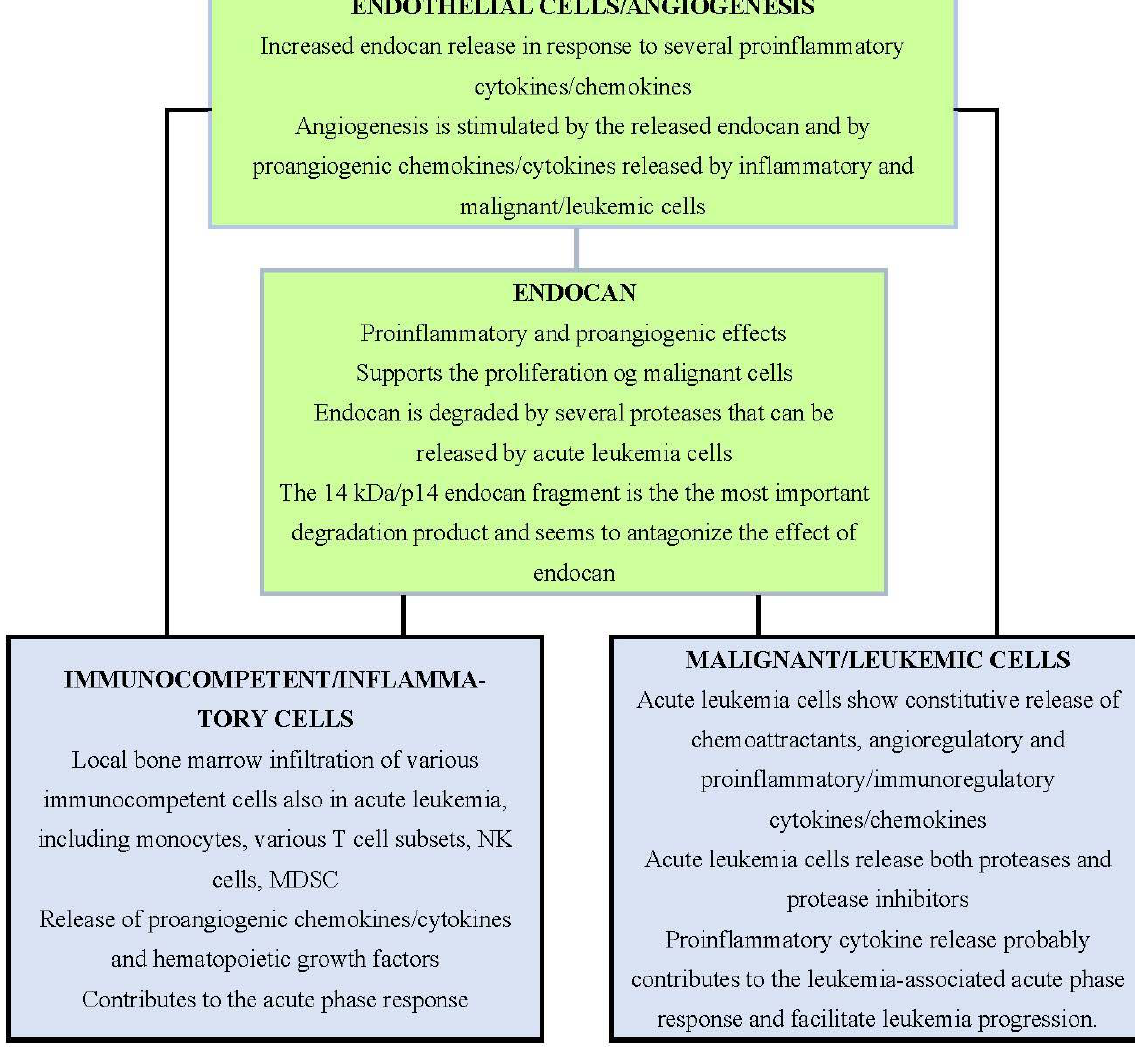
Figure 2. The bone marrow microenvironment in acute leukemia. Endothelial cells, immunocompetent cells, and the malignant/leukemic cells communicate through the extracellular release of soluble mediators and thereby form an interactive triangle. Endocan is released by endothelial cells; this release is modulated by, and also modulates, immunocompetent and inflammatory cells as well as leukemic cells through communication via the release of soluble mediators [2,4,10–12,19– 21,23,31,42–46,50,58,59,67–71].